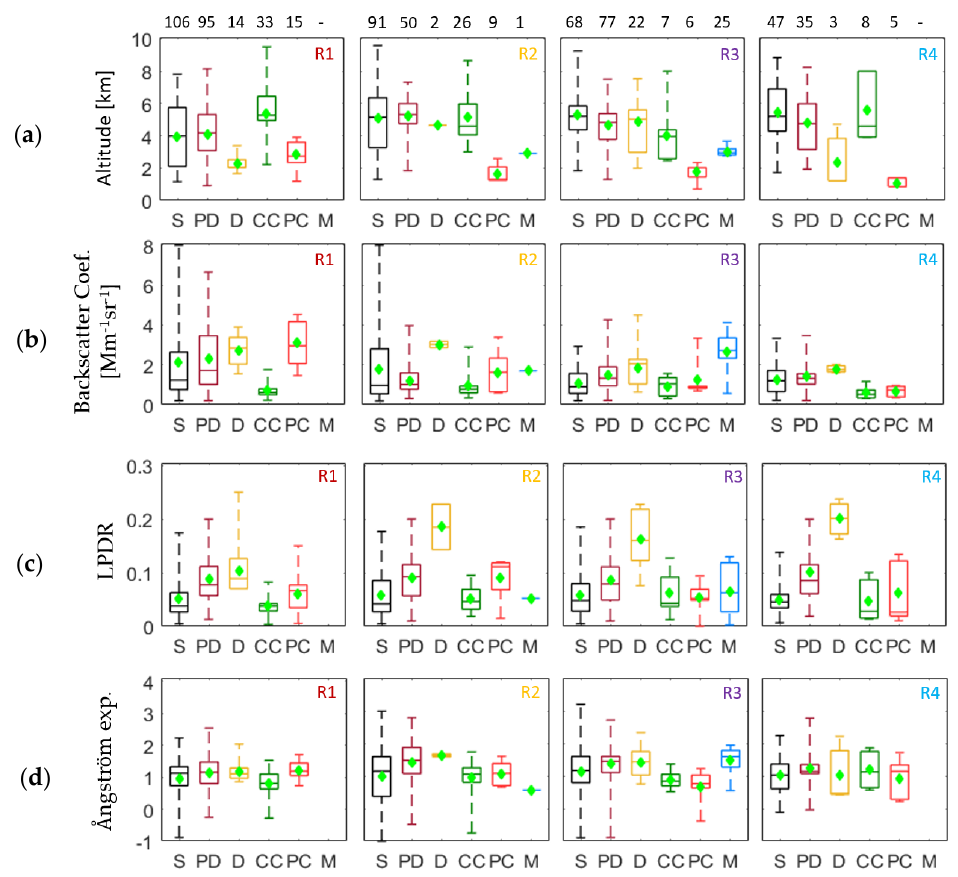
Figure 8. Aerosol layers mixtures according to ( a ) their altitude (amsl.), ( b ) β at 532 nm, ( c ) LPDR at 532 nm, ( d ) AE related to β (532 / 1064 nm). R1–R4 (left to right) correspond to the four subregions (S: pure smoke layers, PD: smoke mixed with polluted dust layers, CC: smoke mixed with clean continental layers, PC: smoke mixed with polluted continental layers, D: smoke mixed with dust layers and M: smoke mixed with marine layers).